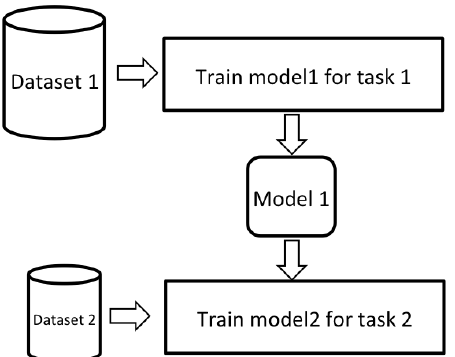
Figure 12. Transfer learning approach: a pre-trained model on another dataset is employed as a starting point to extract the initial representations from another (smaller) dataset.